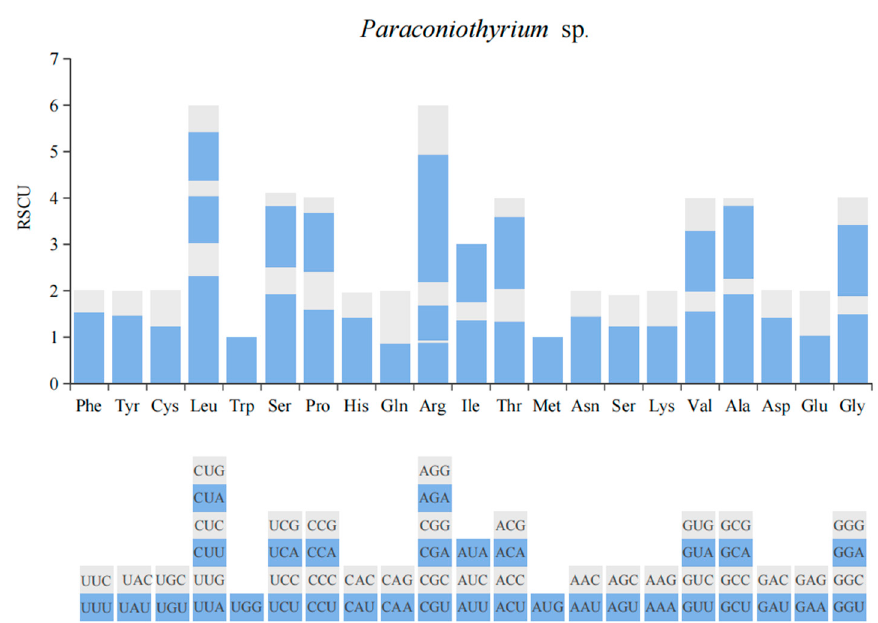
Figure 2. Relative synonymous codon usage